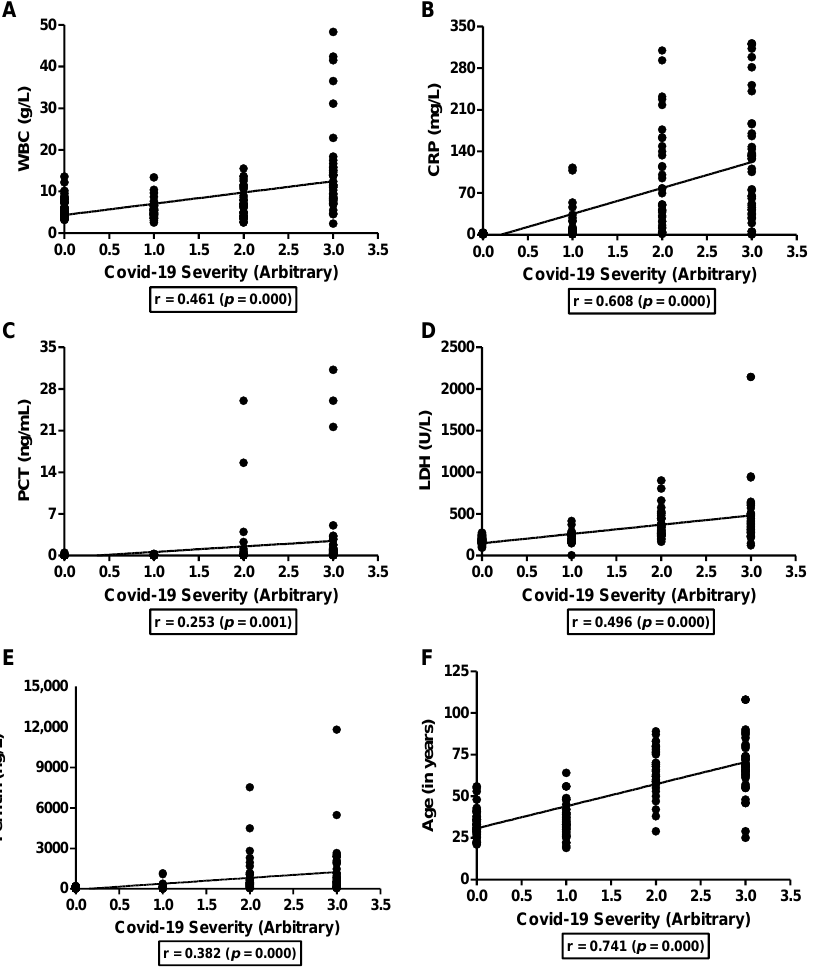
Figure 3. Association of inflammatory markers with the severity of COVID-19 infection. Severity of COVID-19 infection was used to study the association with WBC ( A ), CRP ( B ), PCT ( C ), LDH ( D ), ferritin ( E ), and age ( F ). Correlation was analyzed by Pearson correlation analysis.